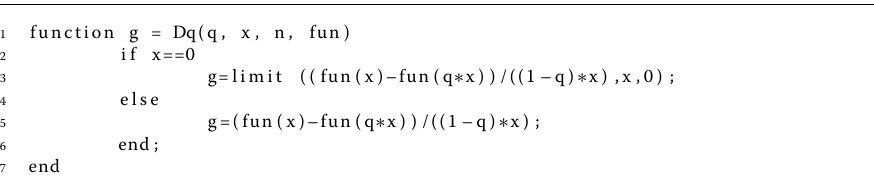
Algorithm 3 The proposed method for calculating ( D q f )( x